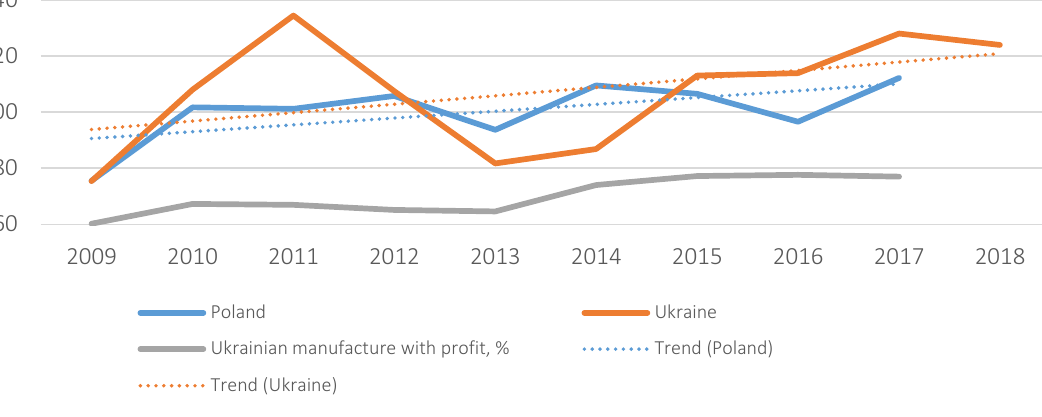
Figure 1. Growth rates of the production value of the manufacture of machinery and